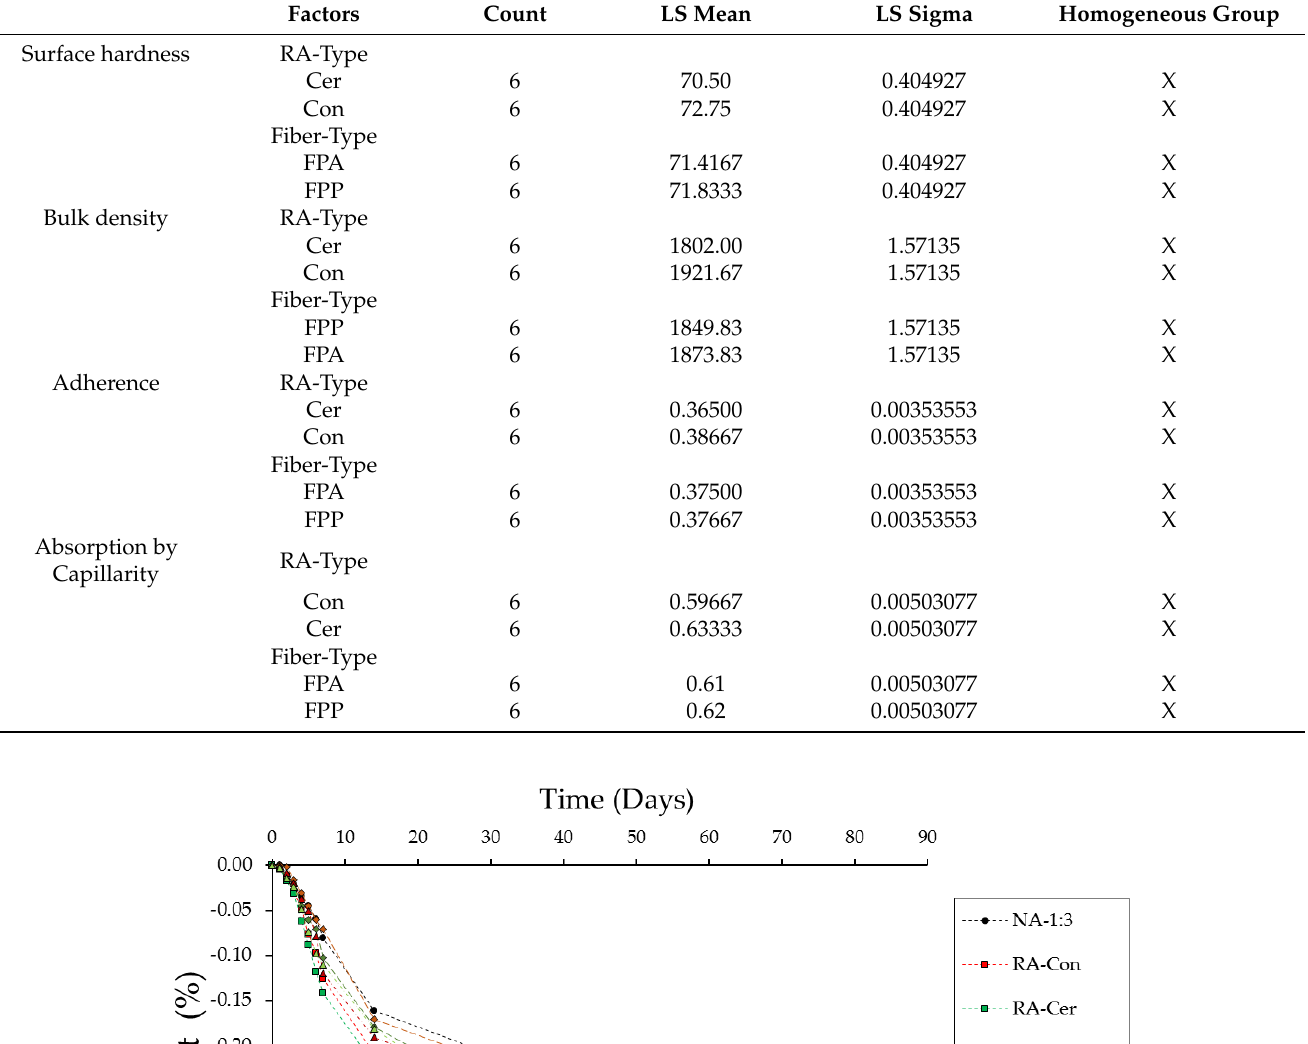
Table 15. Multiple range test for physical properties.